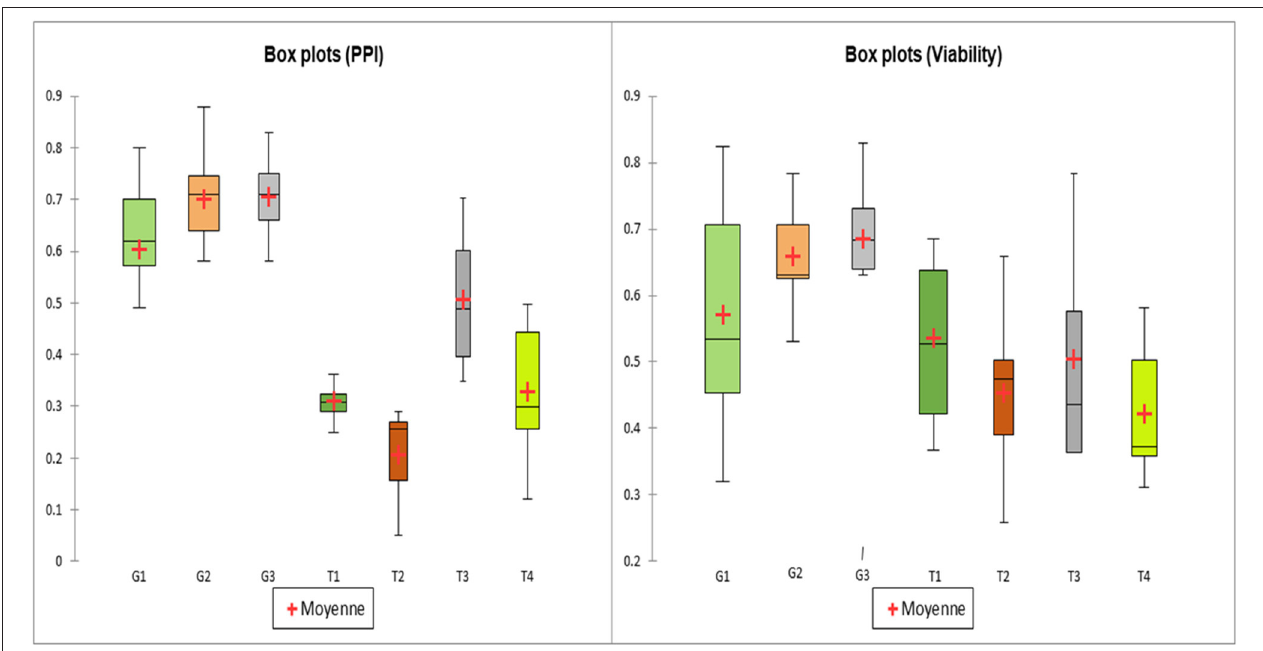
FIGURE 5 | Inter- and intra-heterogeneity of the livelihood outcome indicators for each agropastoral and pastoral systems in the two case studies. G1, Diversified crop-camel-based system; G2, Agropastoral camel-small ruminant system; G3, Specialized pastoral camel-based system; T1, Large agro-pastoral system in Tinghir; T2, Specialized pastoral system in Tinghir; T3, Diversified cattle-small ruminant system in Tinghir; T4, Small scale mixed crop-livestock system in Tinghir.